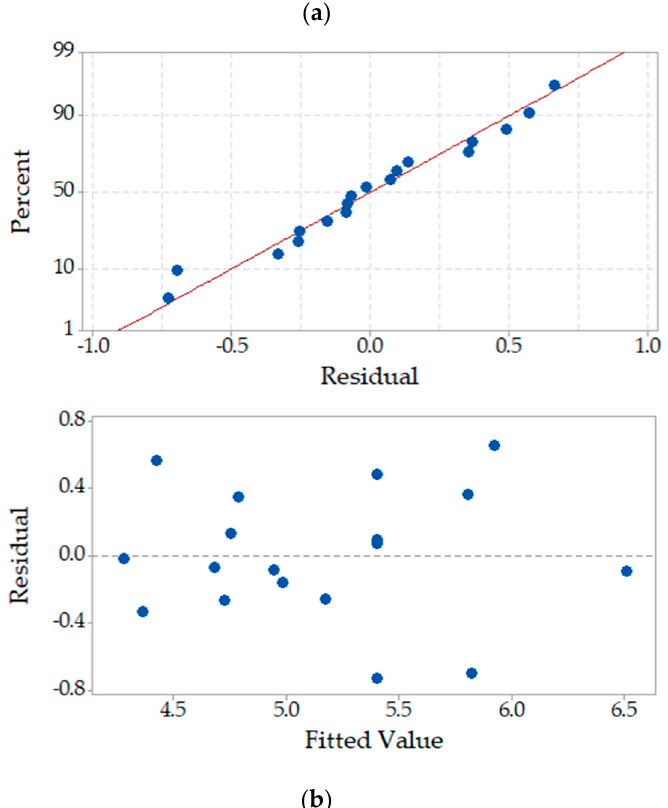
Figure 9. Residual plots for fluoride removal per dry mass of plant. ( a ) Normal probability plot of residuals and ( b ) residuals versus fits. Residuals are randomly distributed and have constant vari- ance.